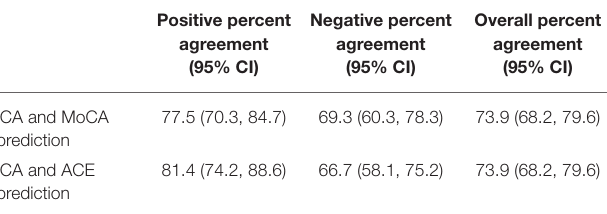
TABLE 6 | Percent agreement between ICA and MoCA, ACE, with 95% confidence